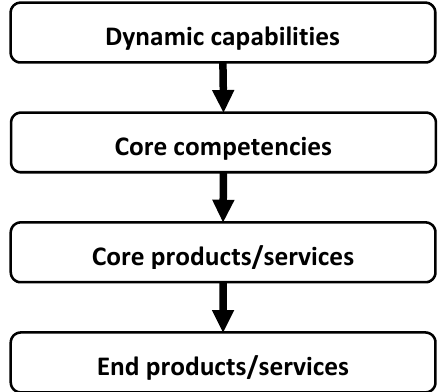
Figure 1. Relationships between dynamic capabilities, core competencies, core products and end products.